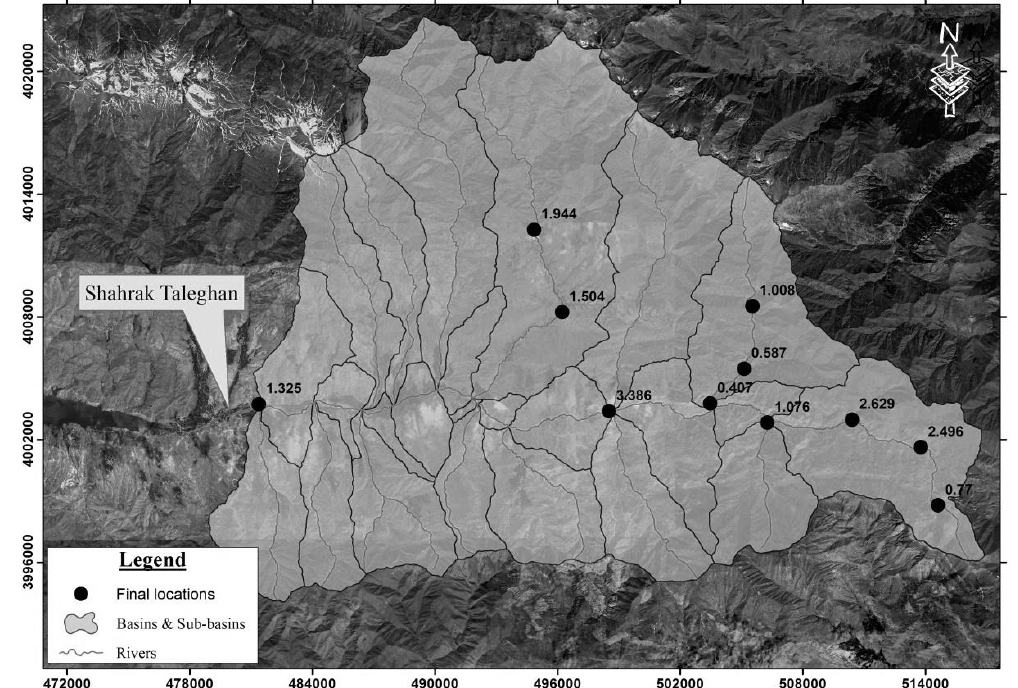
Figure 9 . Final arrangement of the rockfill dams in the Taleghan